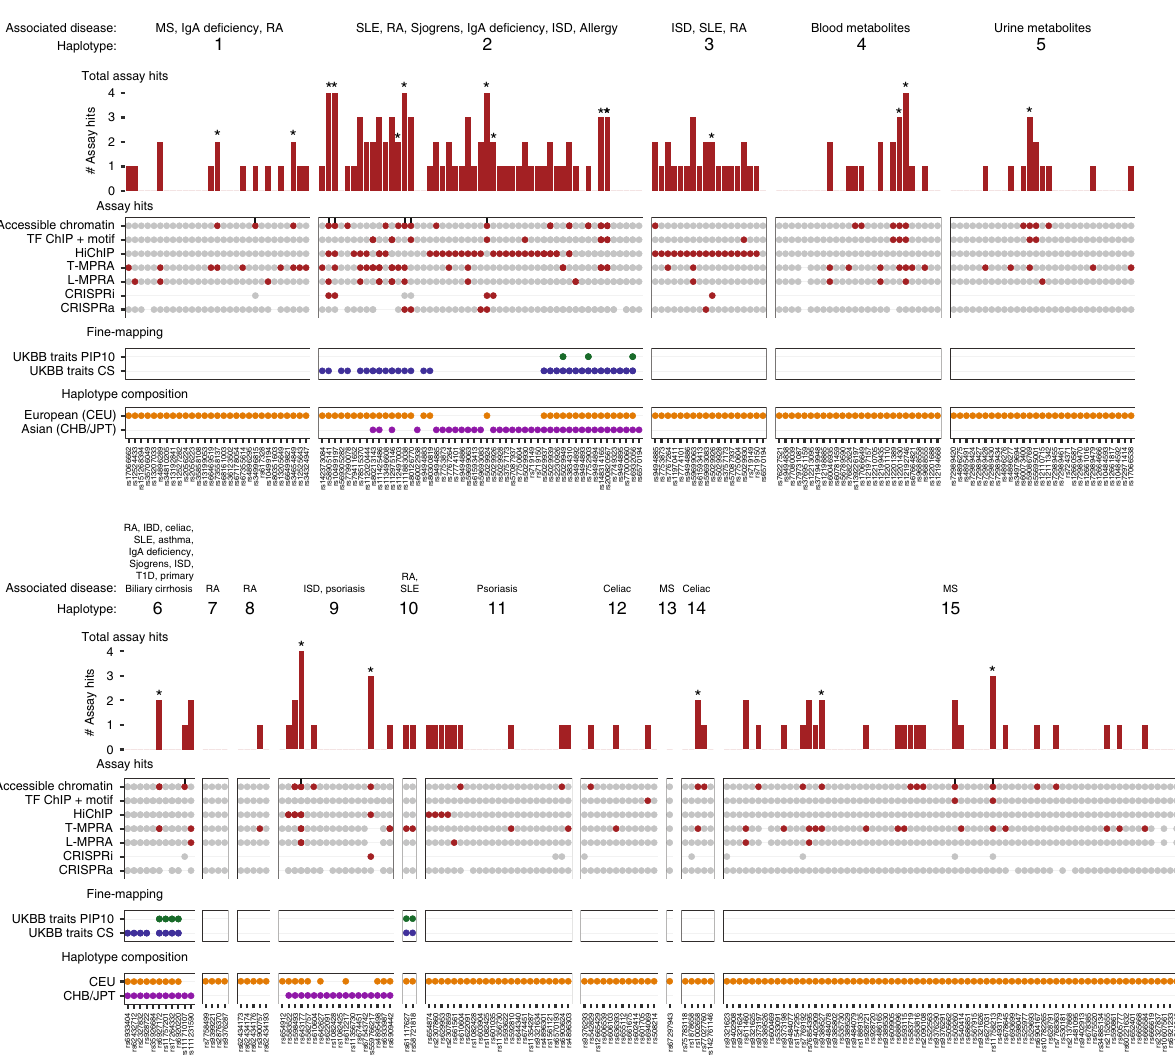
Fig. 4 Prioritizing variants on disease-associated haplotypes. A summary of assay results and genetics data for all SNPs on each disease-associated haplotype. Each subpanel represents a different haplotype, with associated traits and the haplotype number are indicated on the top. For each SNP ( x axes), the total number of assay hits is shown in the bar graph (top) with SNPs that are hits in CRISPRi or T-MPRA hits in accessible chromatin marked with an asterisk. Results from each assay are shown in the middle, with hits in red, and SNPs that are assayed but were not hits in gray for each of the seven assays ( y- axis). The vertical black bars above accessible chromatin SNP status indicate SNPs that were in accessible chromatin in our tested cell lines. Fine- mapped immune-related traits from UK Biobank (UKBB), including SNPs in the 95% credible set (CS — blue) and those that have a posterior inclusion probability > 10% (PIP10 — green) are second from the bottom. The population-speci fi c SNPs contained within each disease-associated haplotype are indicated (bottom) with orange for European (CEU) and purple for East Asian (CHB/JPT). Also see Supplementary Data